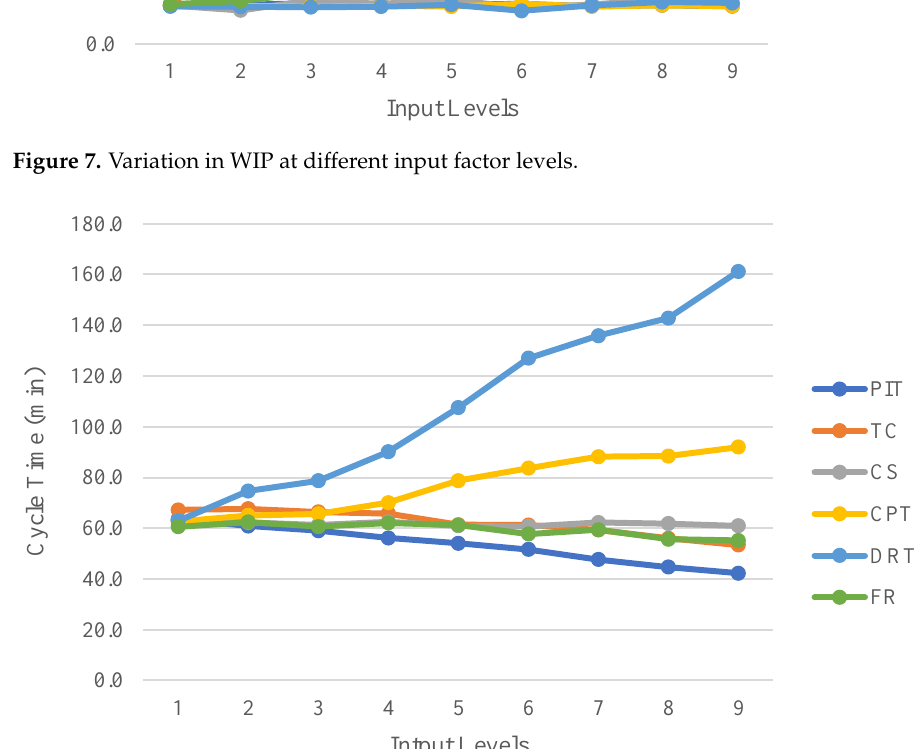
Figure 8. Variation in cycle time at different input factors